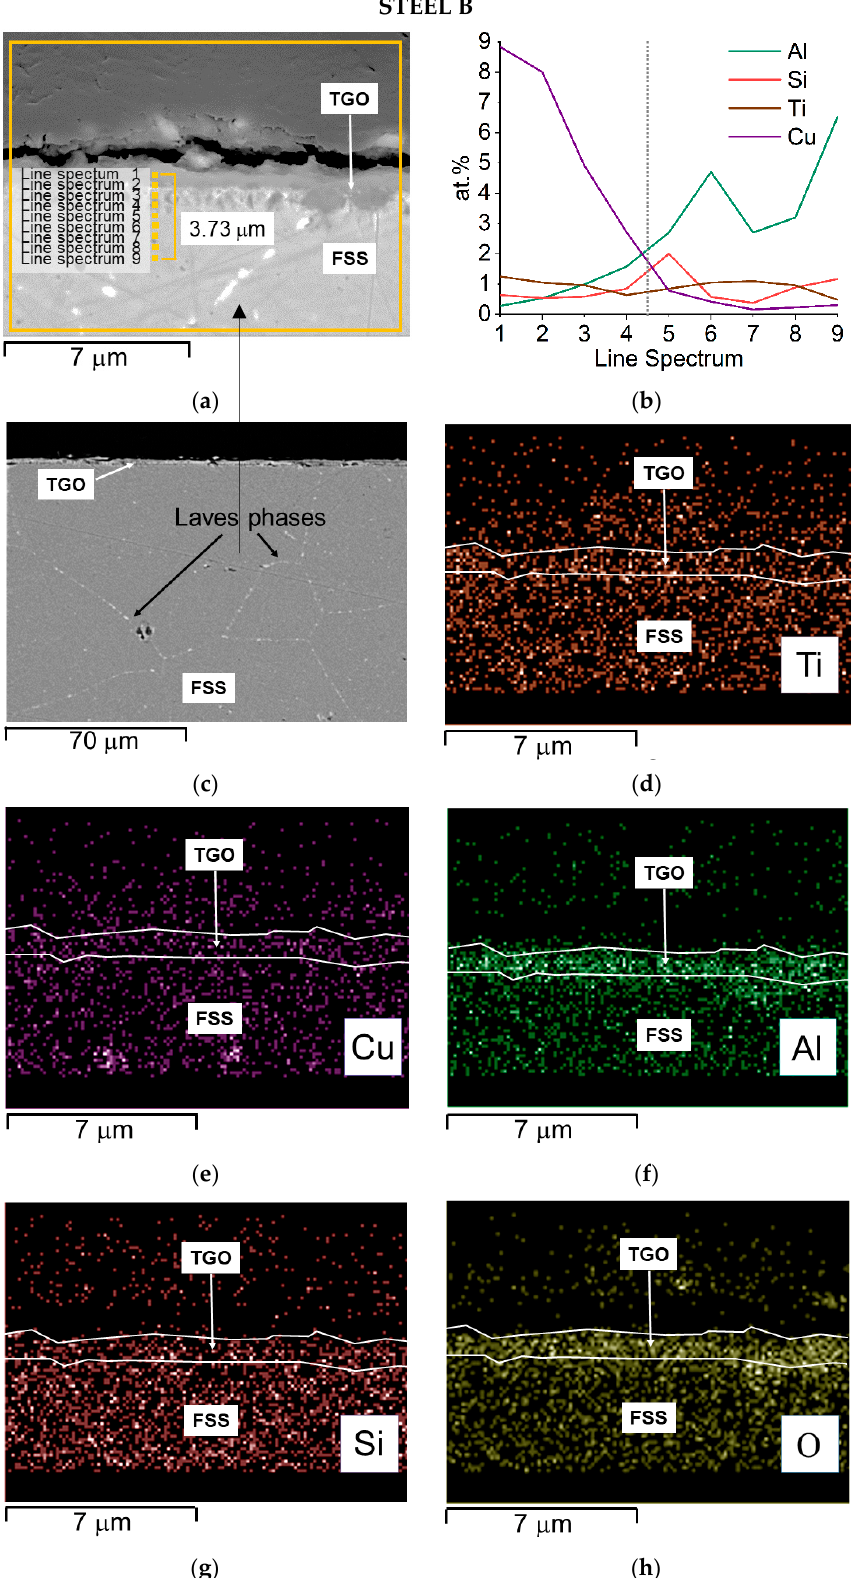
Figure 11. Steel B—SEM-SE micrograph of the oxide scale with spots and area of EDS analyses, 20,000 × ( a ) EDS quantitative profile ( b ), SEM—backscattered electron (BSE) micrograph highlighting Laves phases ( c ), and EDS elemental maps ( d – h